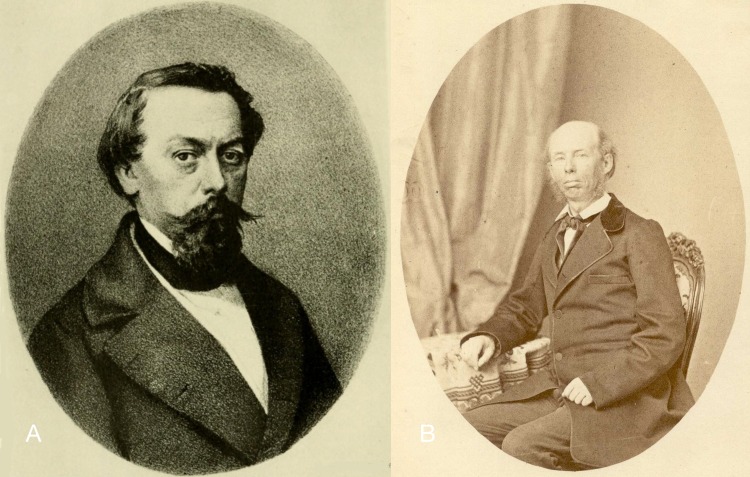
Portraits of persons mentioned in this study.(A) Louis Pfeiffer, 1856 (Wheeler, 1949); (B) Rudolph Philippi, unknown date (CCHS-CSIC).